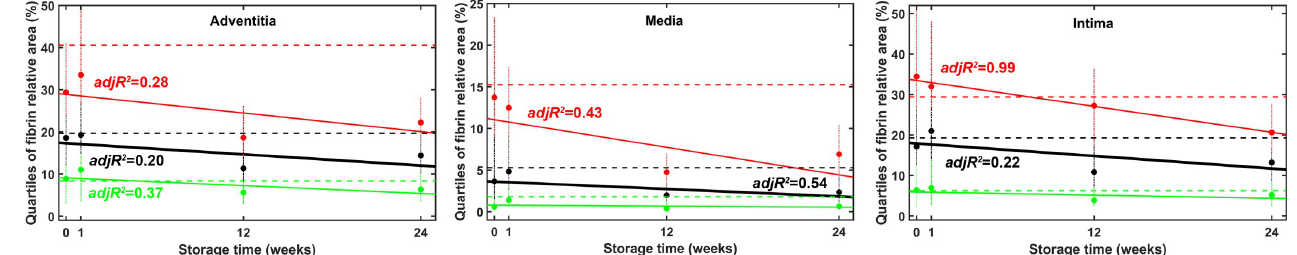
Fig 6. Time course of fibrin deposition in cryopreserved and native arterial allografts. Fibrin coverage of the separate arterial wall layers was measured as illustrated in Fig 3. Lower (green), median (black) and upper (red) quartiles of the measured coverage data are shown with dashed lines for the BC, symbols for the cryopreserved samples and continuous lines for the linear regression performed as described in Materials and Methods. Error bars (vertical dotted lines) indicate the data spanning the range of 12.5% rank below and above the respective quartile value. The explanatory strength of the correlation can be assessed on the basis of the adjusted R 2 (adjR 2 ) values that are shown only for the regression trends proven to be significant at 0.05 level by the statistical approach described in Materials and Methods.